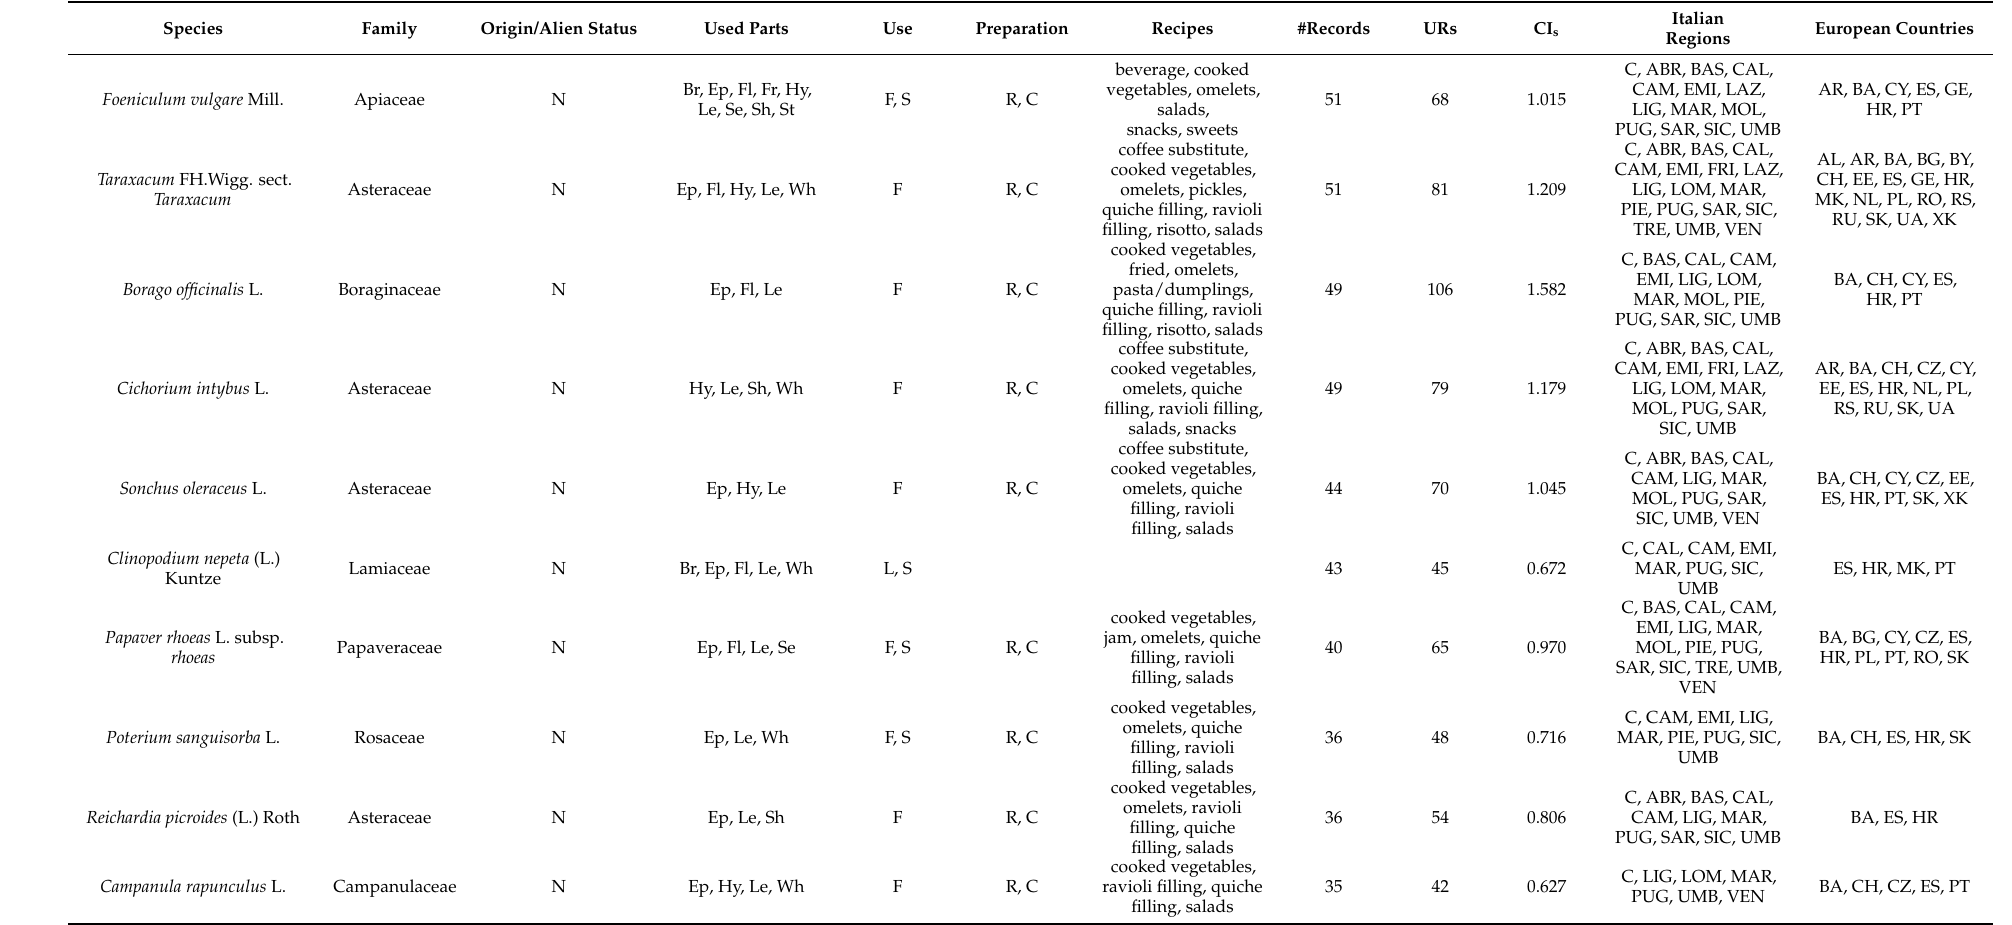
Table 1. List of the 30 most cited taxa in